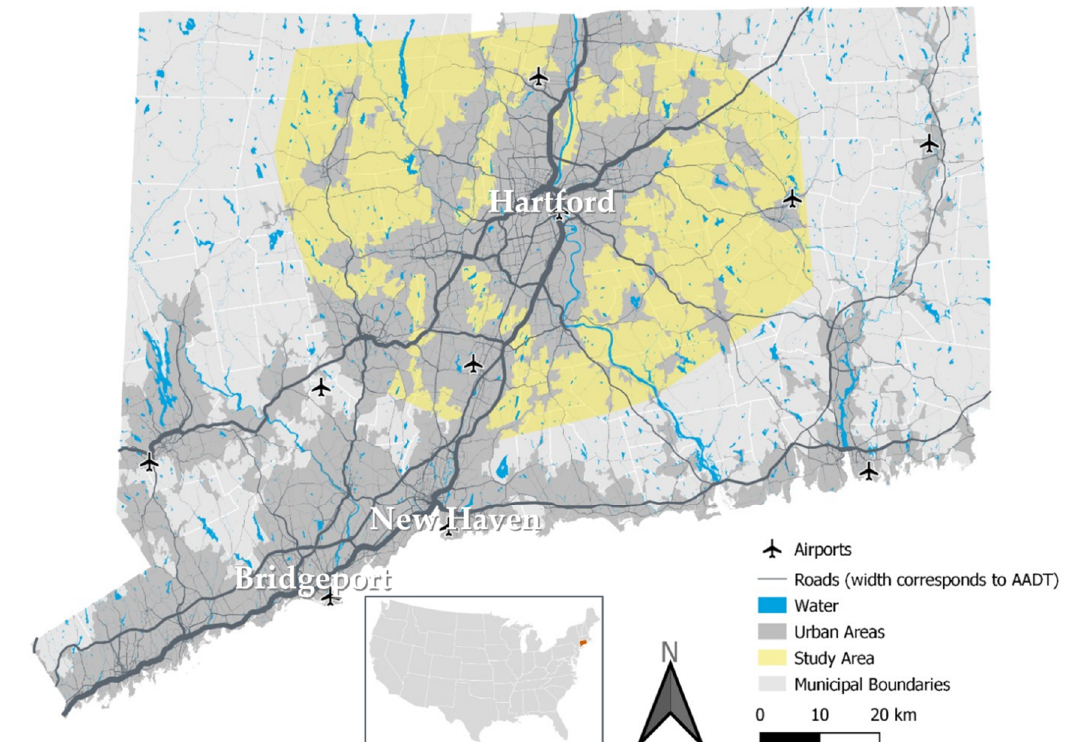
Figure 2. Connecticut, highlighted in red in the inset map, lies in the New England region of the Unites States. The city of Hartford occupies a central position within the state of Connecticut. Highways carry interstate traffic between Boston, Massachusetts (to the northeast), and New York, New York (to the southwest).